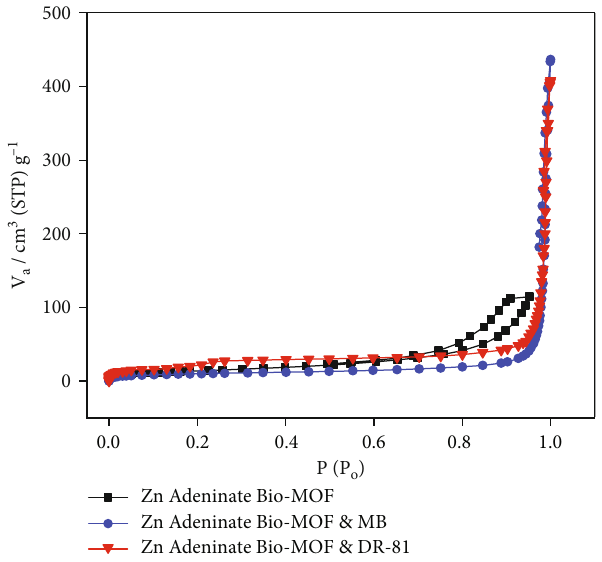
Figure 6: N adsorption/desorption isotherm before and after 2 decolorization of MB and DR-81 by the synthesized Zn-adeninate